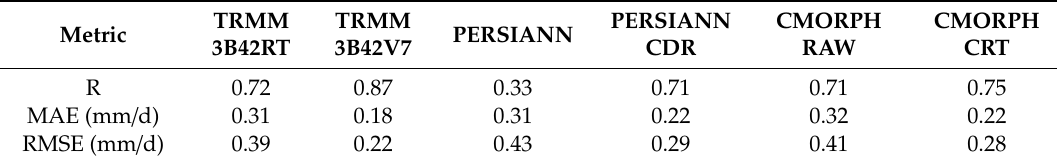
Table 4. SPP evaluation results at an annual scale at a grid scale.